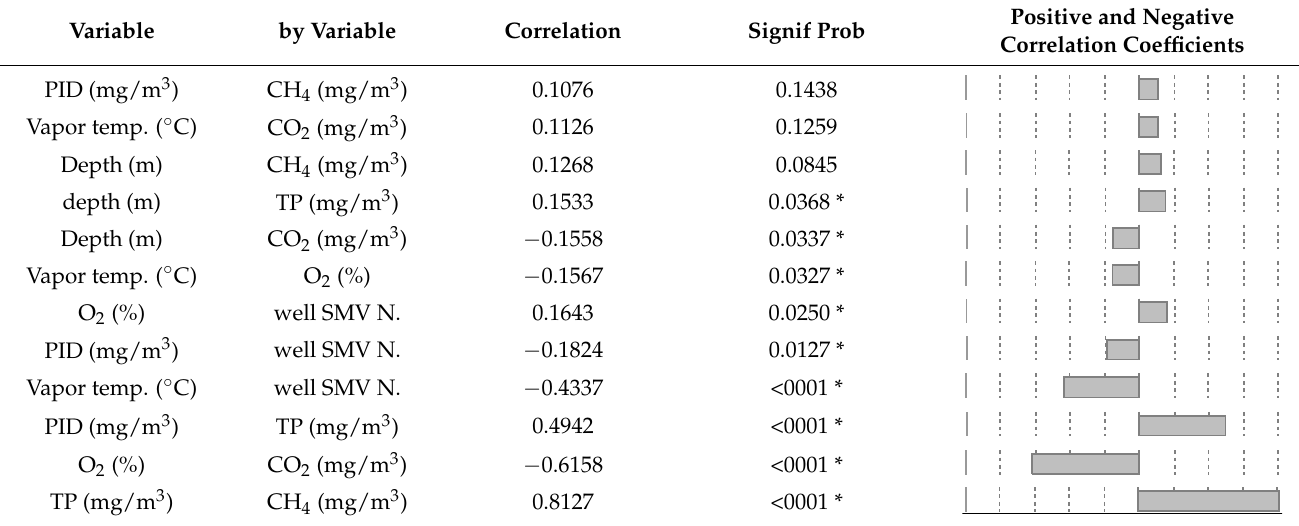
Table 2. Output of paired correlation indicators.